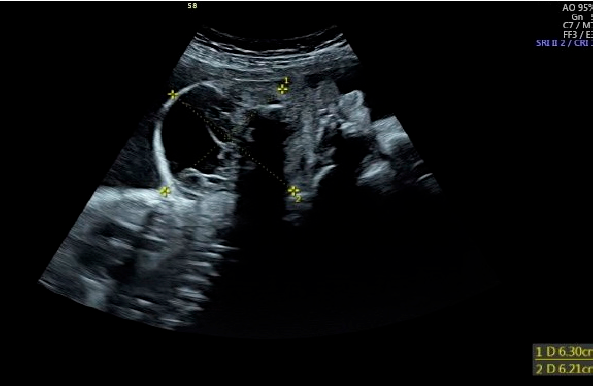
Figure 1. A longitudinal scan of the malformation on the 29th week of gestation. The lesion forced a retroflexed position of the fetal